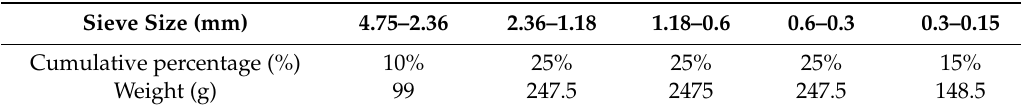
Table 3. Particle size distribution of the waste glass cullet.